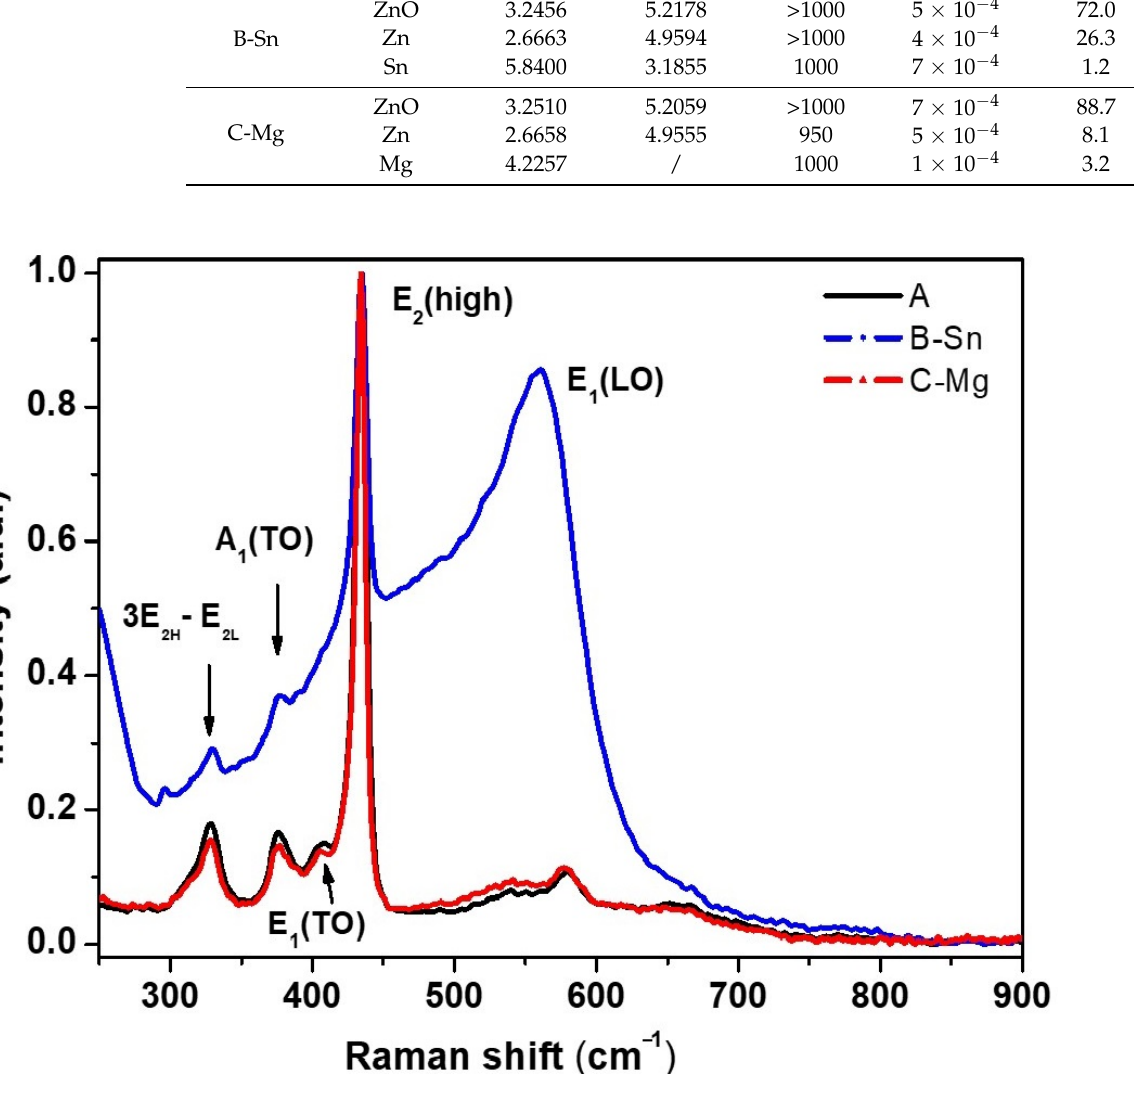
Figure 5. Typical Raman spectra for the heated powder samples A, B-Sn, and